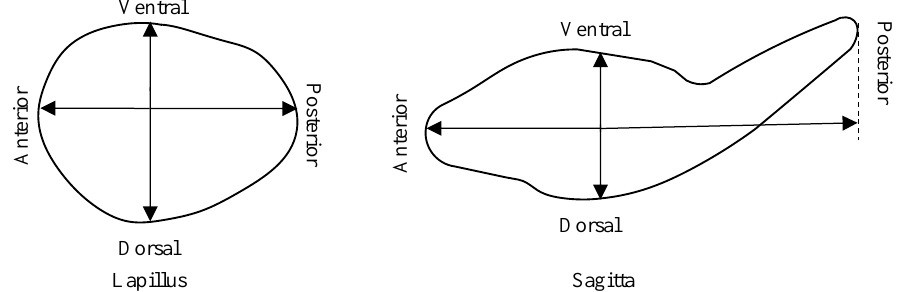
Figure 1. The measured radius of each growth area of lapillus and sagitta.